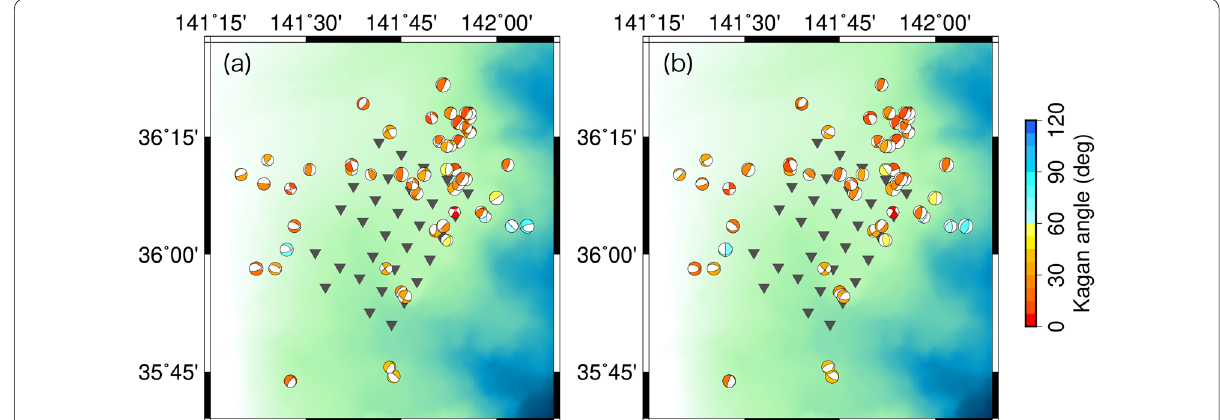
Fig. 7 Spatial distribution of Kagan angles. The colors of the moment tensors suggest the difference in Kagan angles between F-net MT and obtained CMT solutions. a Kagan angles with obtained and b with F-net MT